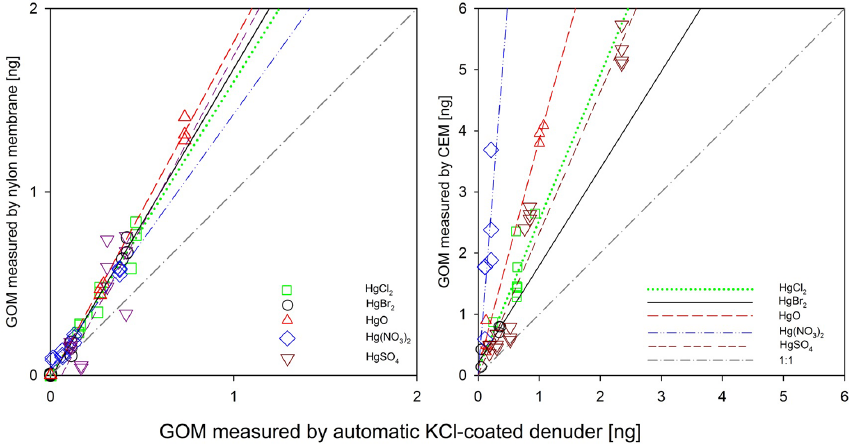
Figure 1. Correlation between GOM concentrations measured by KCl-coated denuder and the nylon and cation exchange membranes in activated charcoal-scrubbed air. Modified from Huang et al. (2013). Table 2. Regression equations comparing nylon membrane and cation exchange membrane measured GOM concentrations to those measured by the denuder using the UNR laboratory manifold system and charcoal-scrubbed